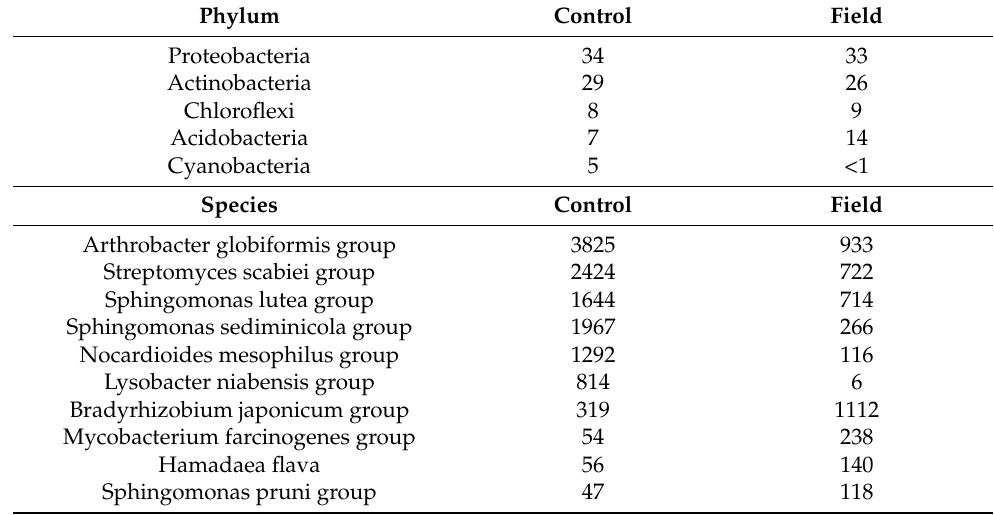
Table 5. Fate of phylum and species of bacteria in control and field soils (contaminated